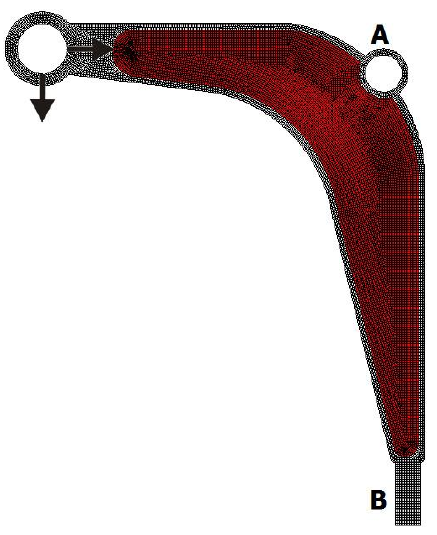
Figure 21. The control arm: dimensions in mm.